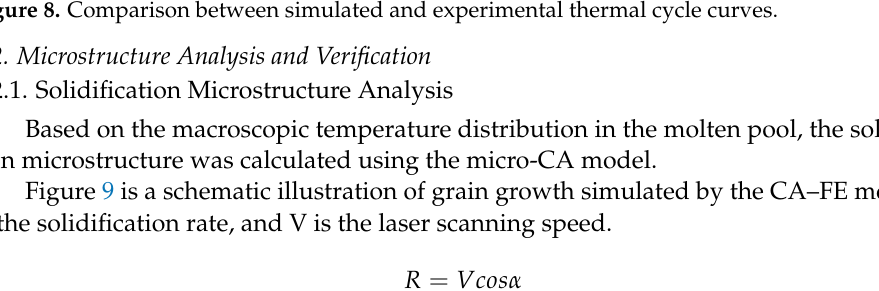
Figure 9. Schematic illustration of grain growth: ( a ) longitudinal cross-section; ( b ) transverse cross- section.